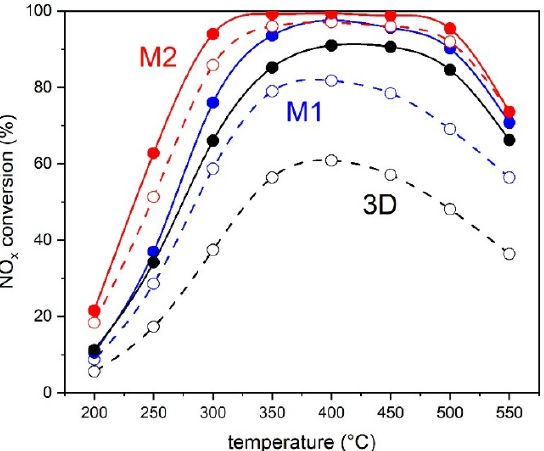
Figure 8. Maximum NO x conversion (solid lines) and NO x conversion at 10 ppm NH 3 slip (dashed lines) of the three samples M1, M2, and 3D-printed.